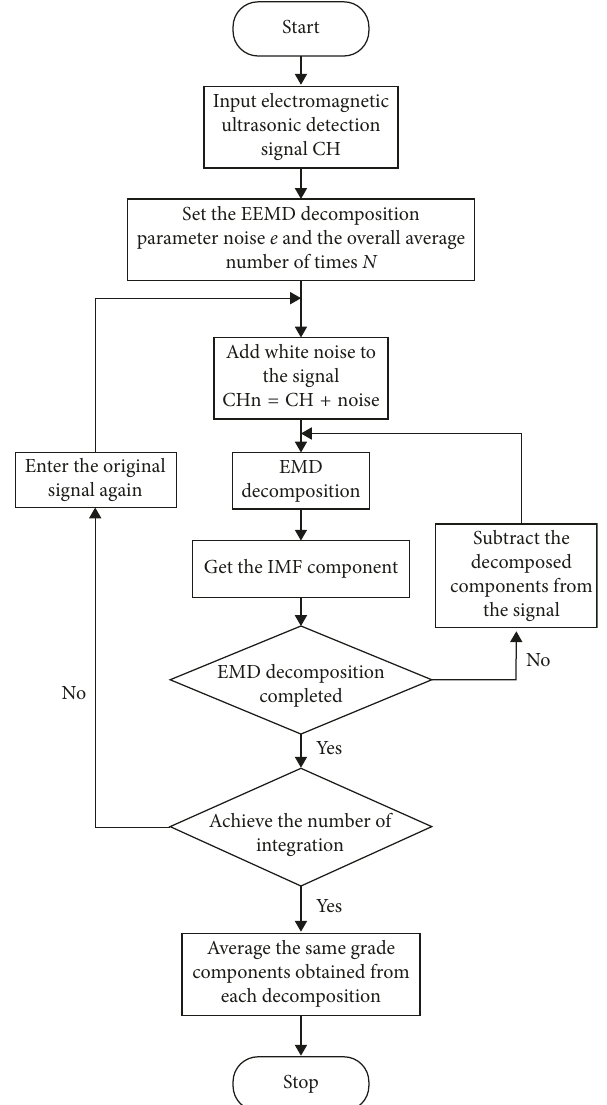
Figure 3: Processing flow of